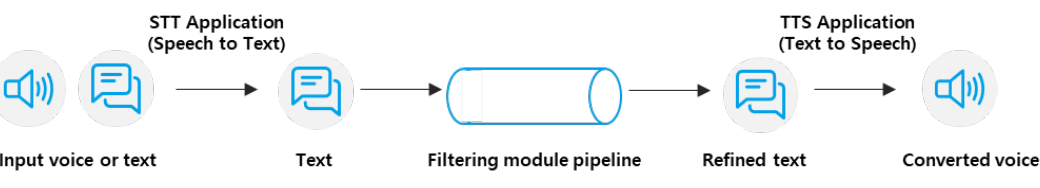
Figure 7. Communication method.